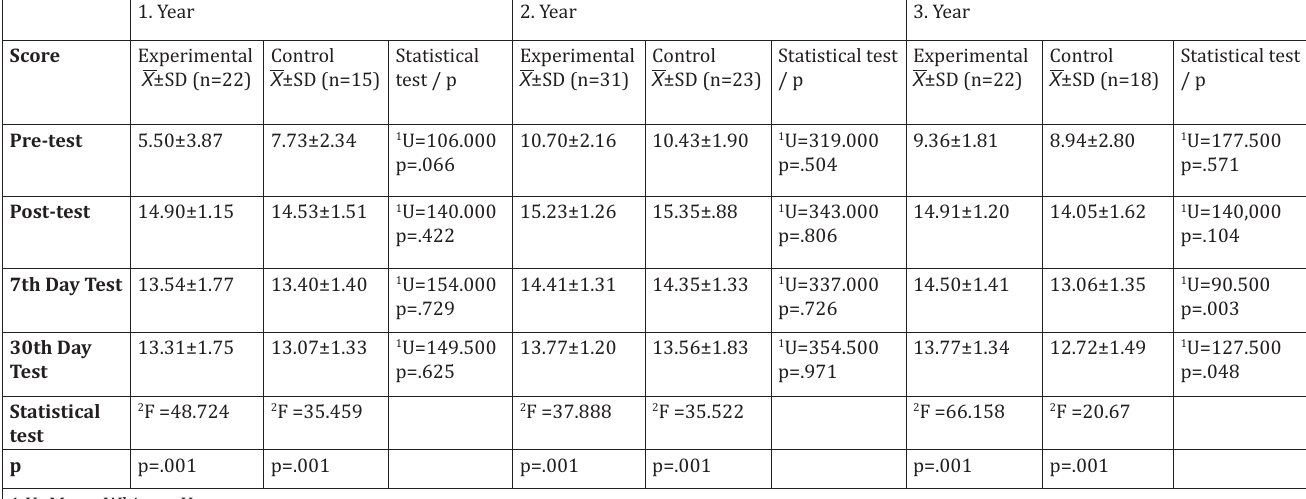
A Comparison of the Experimental and Control Groups’ Mean Scores by Year of Study 1.